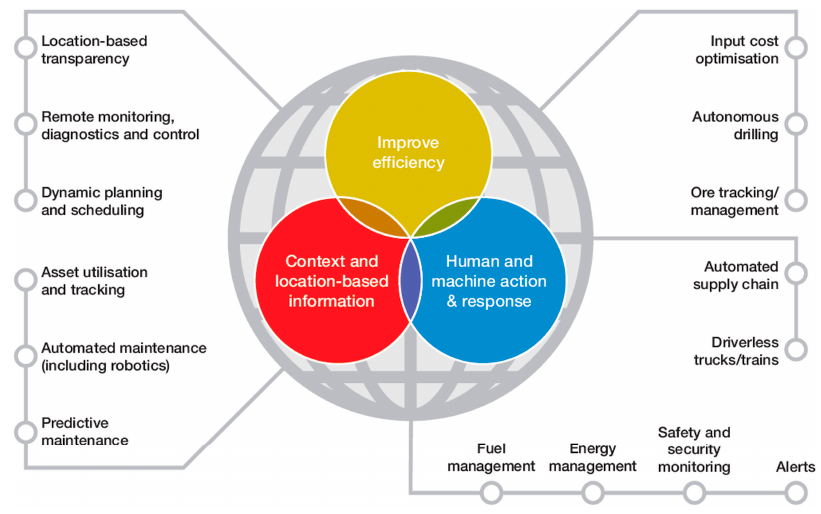
Figure 6. Internet-connected things in mining (Reprinted from Ref. [53]).